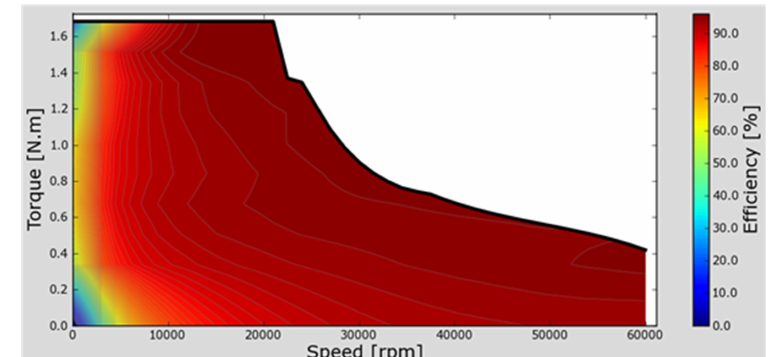
Figure 15. Efficiency MAP Diagram of the